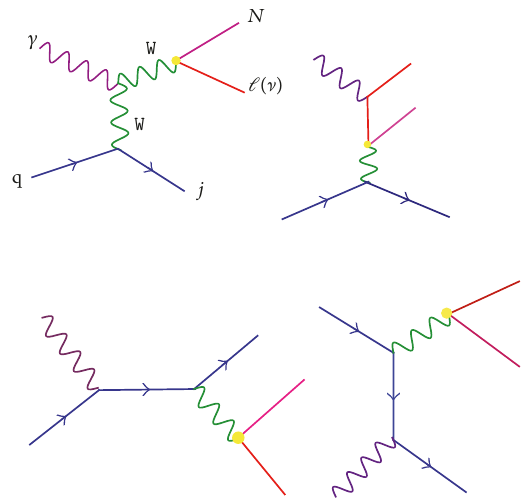
Figure 9: The photon initiated 𝑁ℓ𝑗 final state. The 𝑁 ] 𝑗 final state can also be obtained; however, the contribution will be low as 𝛾 → 𝑍𝑍 vertex is absent due to the gauge